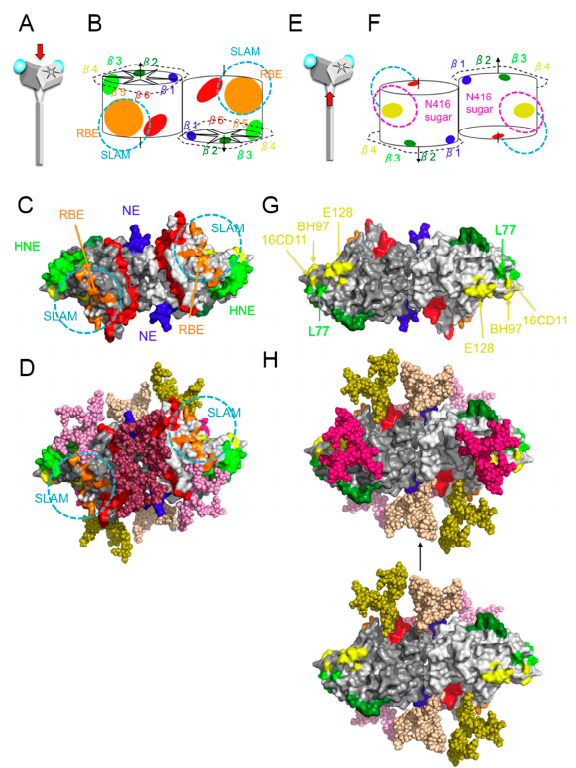
Figure 3. Dimer structure of the MV-H protein and models of N-linked sugar modifications. ( A , E ) Red arrows in ( A ) and ( E ) indicate the direction of sight for ( B – D ) and ( F – H ), respectively. ( B , F ) Schematic diagram. Light green, blue, and green ovals indicate locations of HNE, NE, and LE, respectively. Black solid lines and dashed lines indicate the overall structure of the H protein. Magenta and cyan dashed lines indicate locations of N416-sugar and SLAM, respectively. ( C , G ) Surface presentation models. Amino acids demonstrated or suggested to constitute a portion of an epitope are shown in colors: residues on β -sheets 1, 2, 3, 4, 5, and 6 are shown in blue, red, orange, yellow, light green, and green, respectively. ( D , H ) Surface presentation models with N-linked sugar modifications constructed with GlyProt. N-linked sugars are shown with sphere models. ( H ) Upper structure has N416-sugar and lower structure lacks N416-sugar.